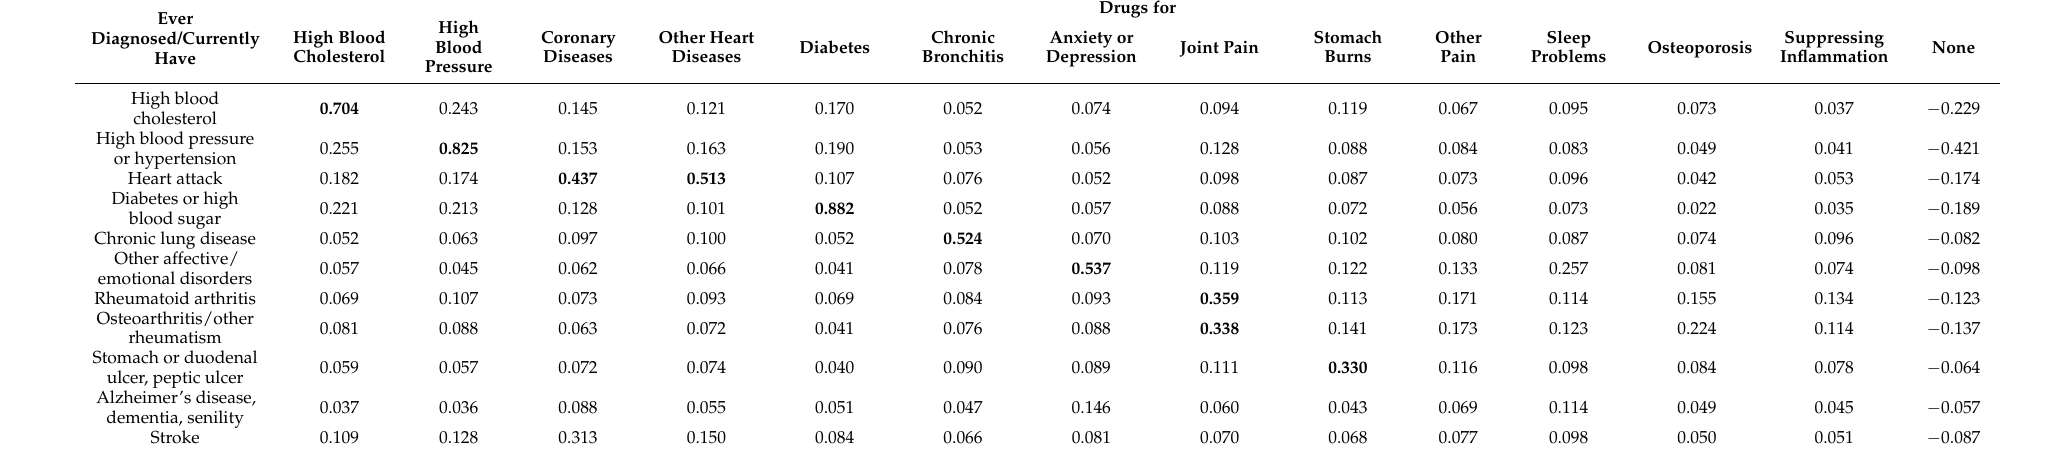
Table 2. Correlation between the reporting of distinct disorders and drug